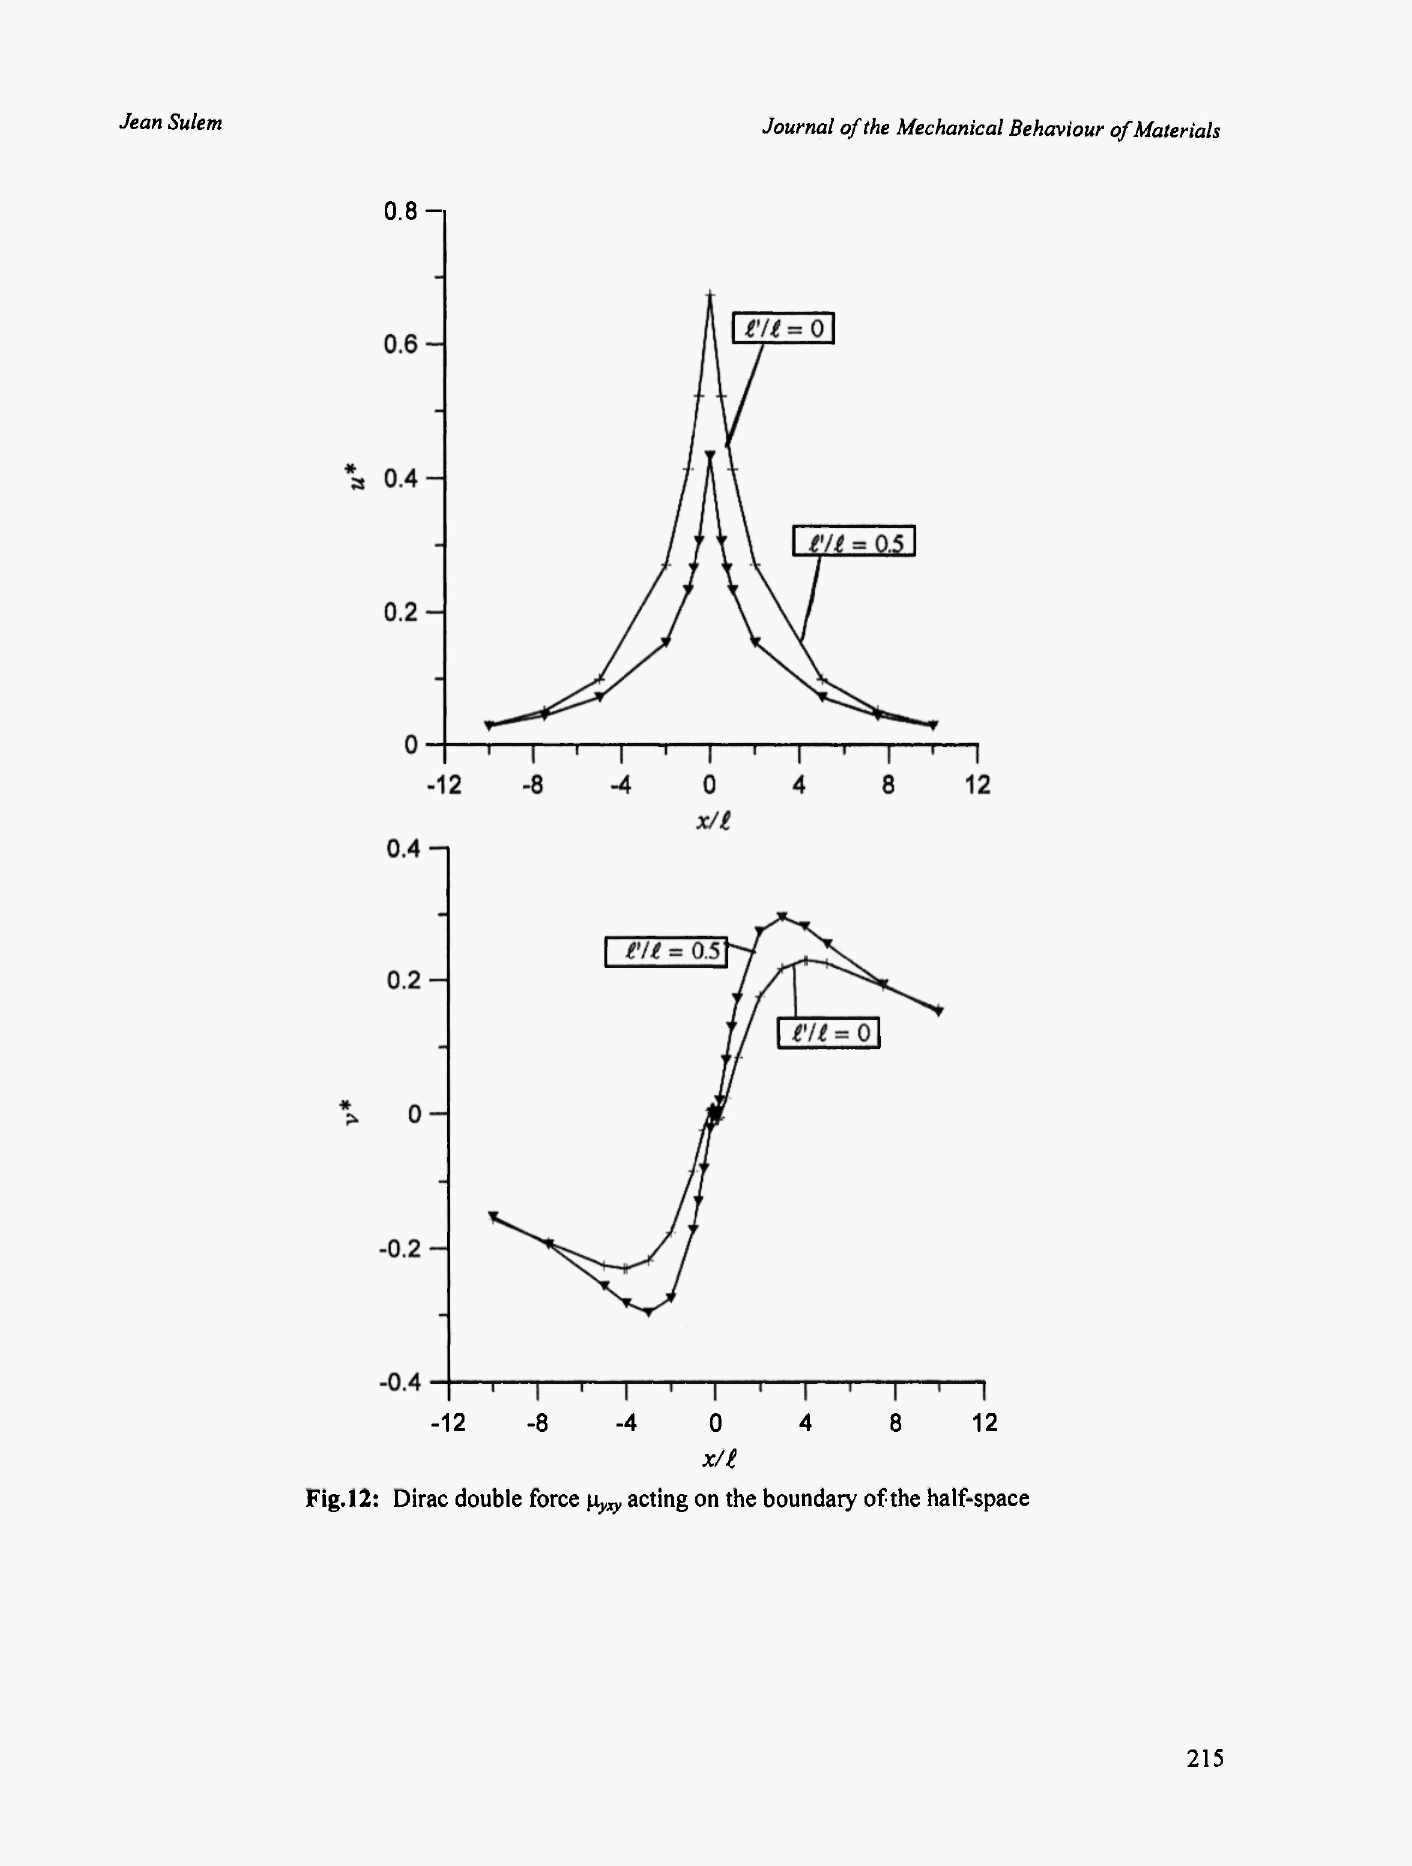
Fig.12: Dirac double force \x yxy acting on the boundary of the